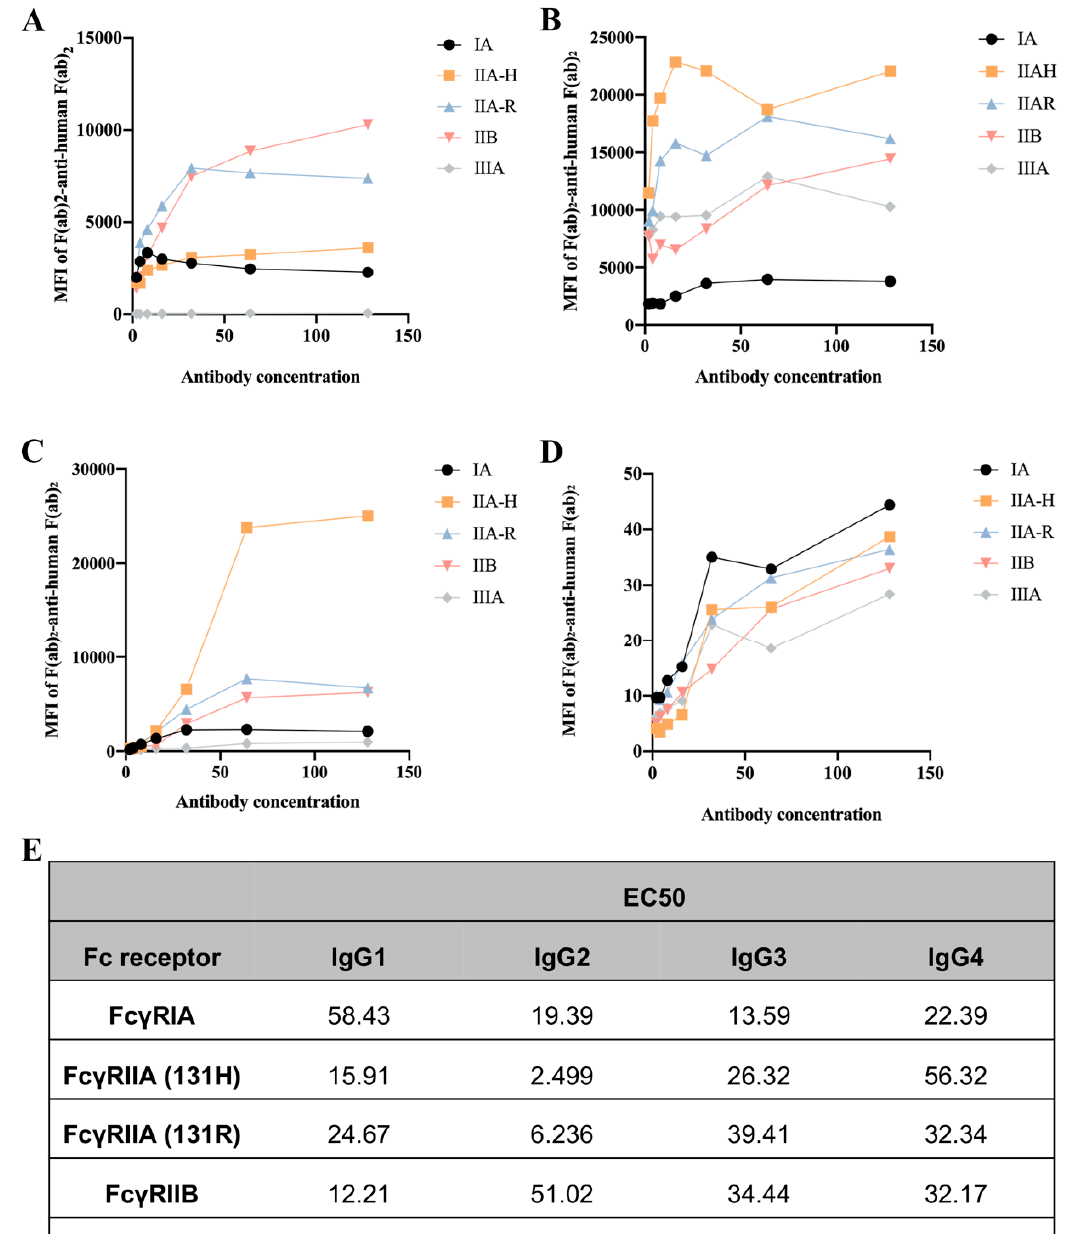
Figure 1. Affinity between the CVI recombinant antibodies of different subtypes and Fc γ Rs. ( A ) Affinity of IgG1 for Fc γ Rs. ( B ) Affinity of IgG2 for Fc γ Rs. ( C ) Affinity of IgG3 for Fc γ Rs. ( D ) Affinity of IgG4 for Fc γ Rs. ( E ) EC50 results of Fc γ R binding to the CVI recombinant antibodies of different subtypes. n ≥ 3 independent experiments.